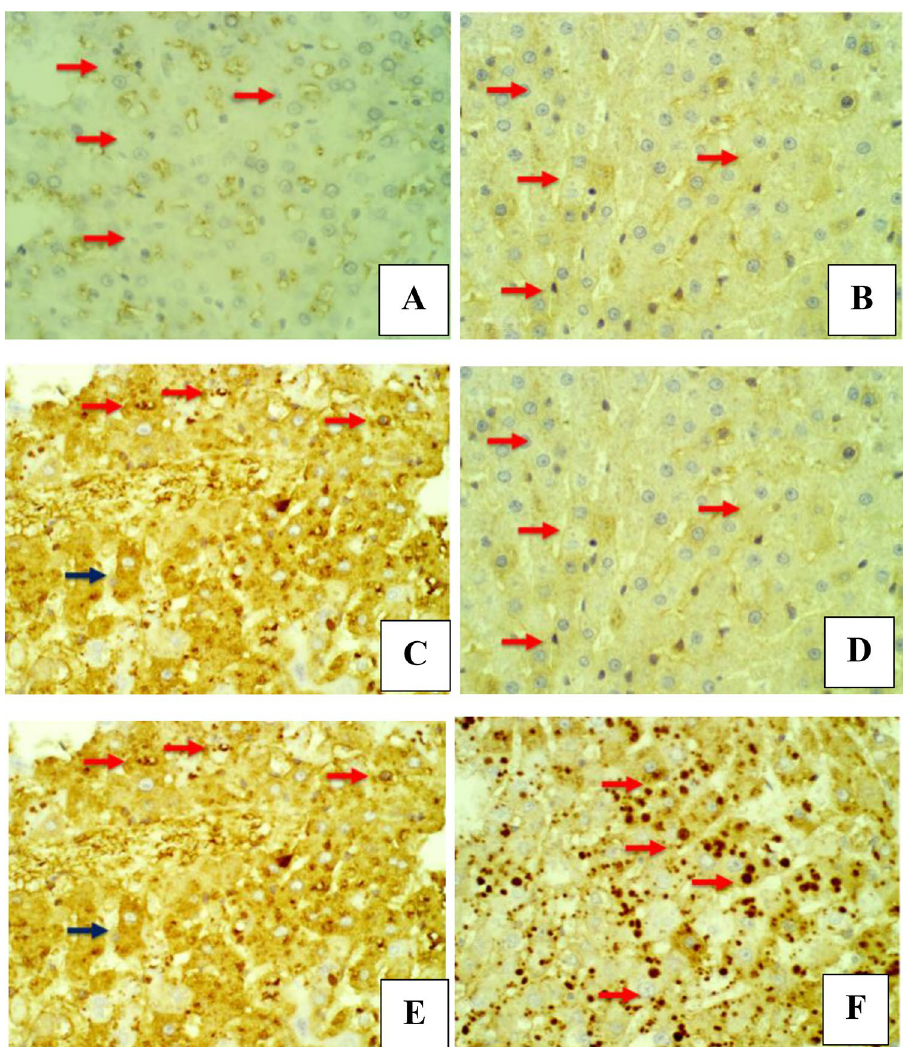
Ki67 antibodies in the nucleus of hepatocytes (red arrow). ( C ) DEN group/ 3 weeks, shows positive staining with Ki67 antibodies in the affected hepatocytes which stained the nucleus as dark brawn color (red arrow), notice unspecific staining in other cellular elements (black arrow). ( D ) DEN group/6 weeks, shows positive staining with Ki67 antibodies in the affected hepatocytes which stained the nucleus as dark brawn color (red arrow). ( E ) 5B2T group/3 weeks, shows few positively staining nucleus of hepatocytes with Ki67 antibodies (red arrow). ( F ) 5B2T group/6 weeks, shows negative staining nucleus of hepatocytes with Ki67 antibodies (red